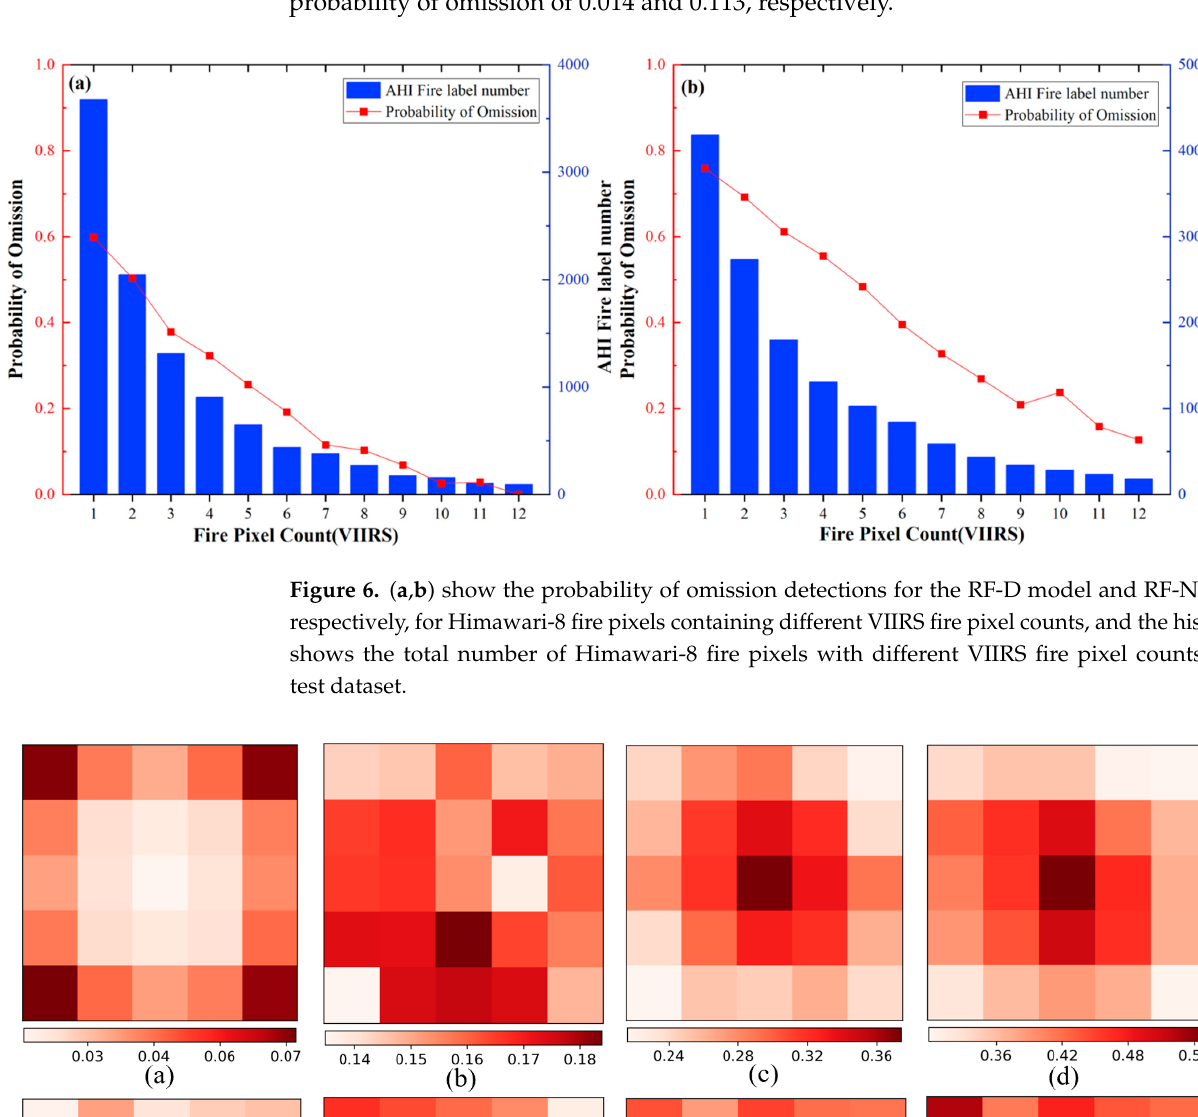
which appeared at the edges of the Himawari-8 pixel, most notably, at the four corners. The probability of appearing at the center of the pixel was smaller, and the probability of within the Himawari-8 pixel increased, the VIIRS fire pixel position gradually shifted